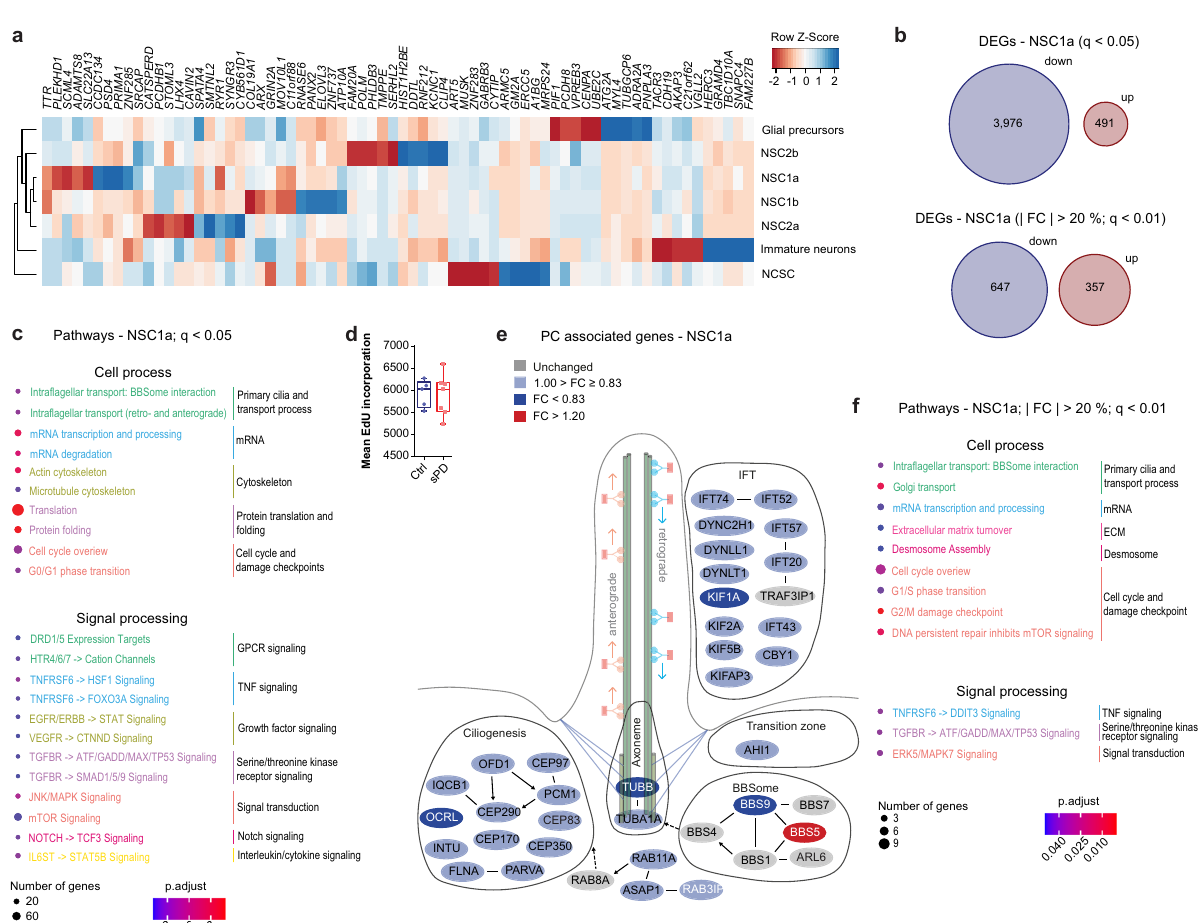
transport: BBSome interaction ” pathway with manual annotations. Up- (red) and downregulated (blue) genes are sorted into functional categories intra fl agellar transport (IFT), transition zone, BBSome, axoneme, and ciliogenesis. Color inten- sity is proportional to fold change. f Enriched pathways of the categories Cell process and Signal processing analyzed using Pathway Studio for the DEGs of NSC1a(|FC|>20%; q <0.01). P -valuesweredeterminedbyone-sidedFisher ’ sexact tests. FDR corrected p -values are represented by q -values. Boxplots display the median and range from the 25th to 75th percentile. Whiskers extend from the min to max value. Each dot represents one patient. # p <0.1, * p <0.05, ** p <0.01, *** p <0.001. Source data are provided as a Source Data fi